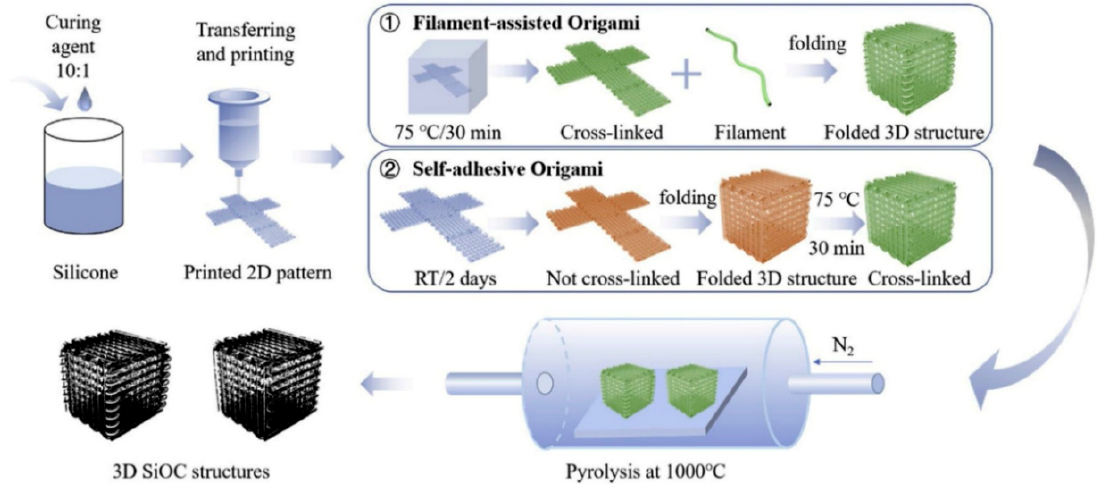
Figure 2. Schematic of the fabrication of SiOC samples with complex architecture from 3D printing and origami technique [13]. Reproduced with permission from Huang K., Addit. Manuf.; published by Elsevier, 2020.